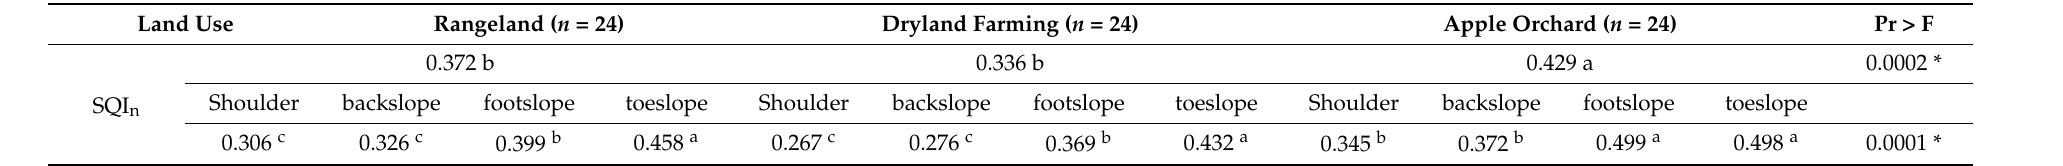
Table 3. Comparison of the mean values of soil quality indices in different land uses and slope